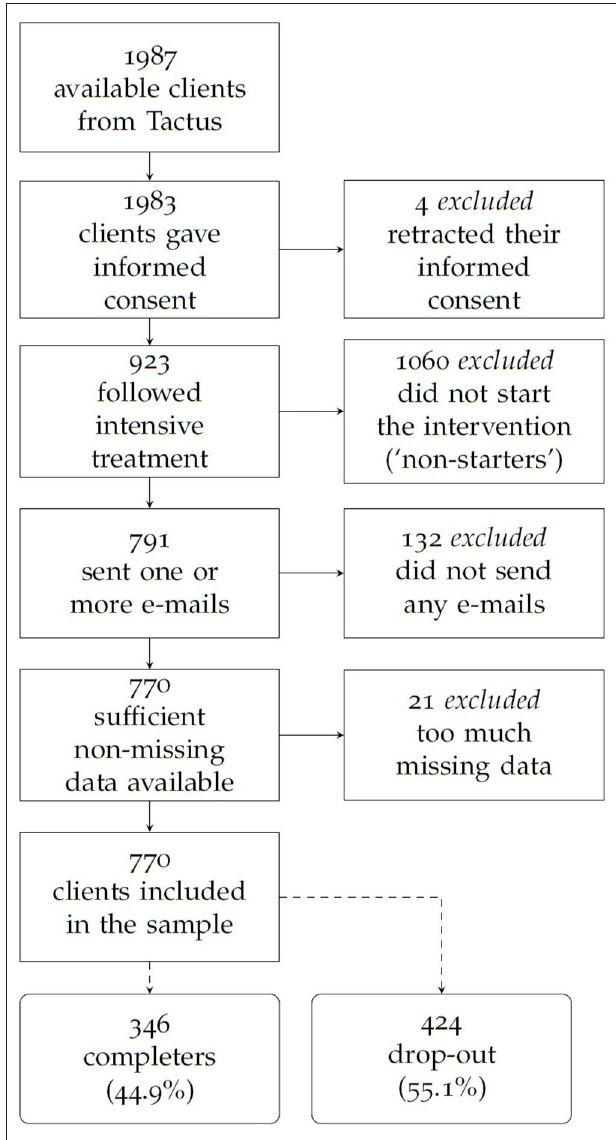
FIGURE 1 | Flowchart of the (excluded)